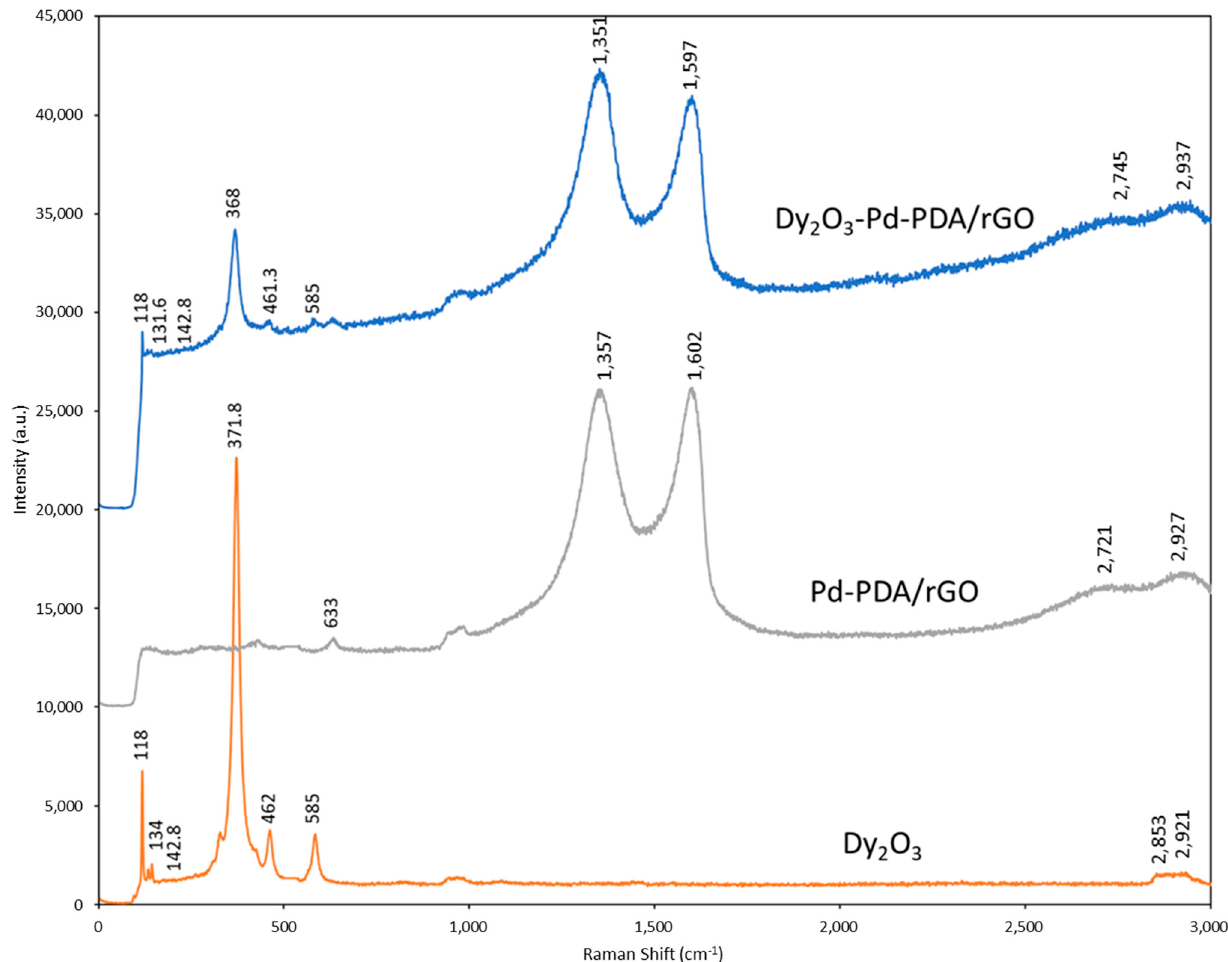
Figure 7. Raman analysis of Dy 2 O 3 -Pd-PDA/rGO nanocomposite, Pd-PDA/rGO, and Dy 2 O 3 .